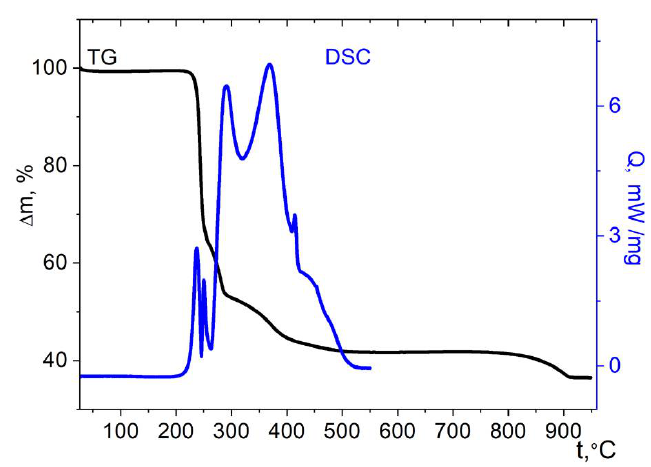
Figure 15. Thermolysis of complex 7 under air.